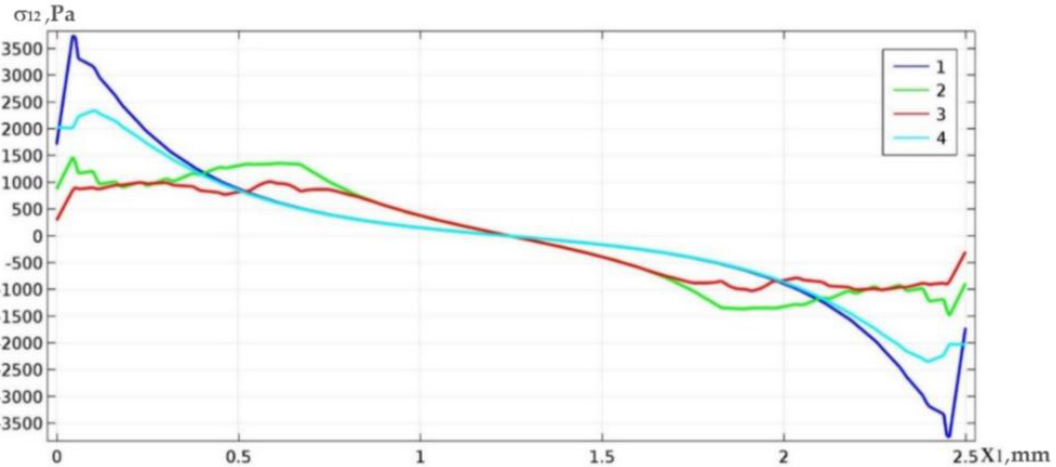
Figure 7. Curves of the distribution of shear stresses along the upper (1,2) and bottom (3,4) boundary of the solder area.